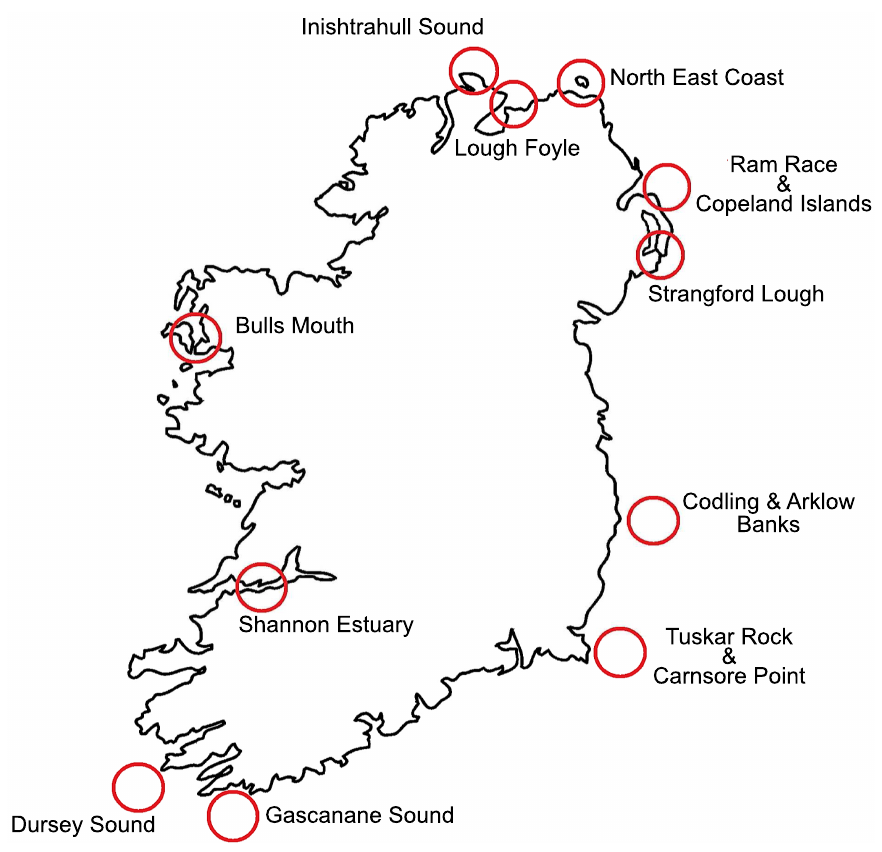
Figure 1. SEI locations